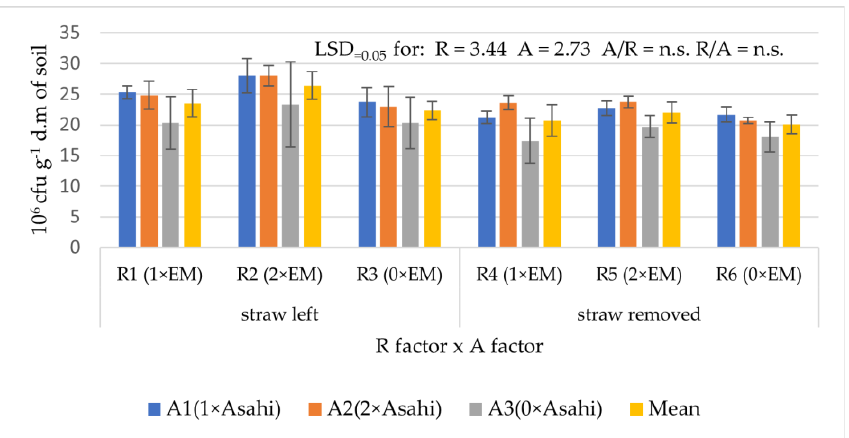
Figure 1. The number of bacteria in the soil, depending on the management of plant residues with the addition of the biopreparation EM (R factor) and the application of the biostimulant Asahi (A factor) in spring barley cultivation. Error bars represent standard deviation (abbreviations: see Table 1). Table 6. Index of relative changes (Ic) in the abundance of the analyzed groups of microorganisms in the soil after 2 years of exposure to experimental